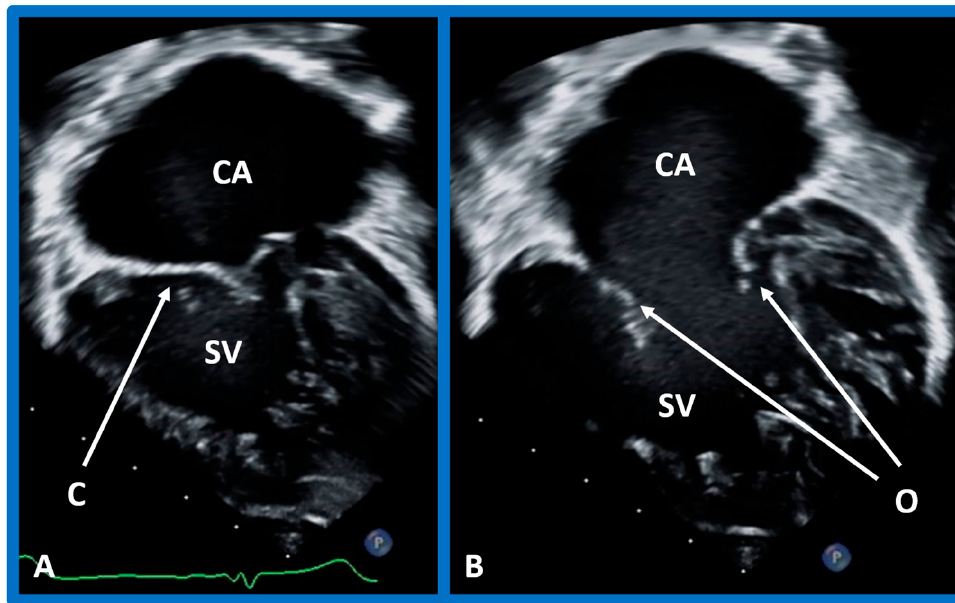
Figure 43. Echo frames in apical four-chamber views demonstrating a connection of common atrium (CA) with single ventricle (SV) by a one (common) atrioventricular valve. In ( A ), the common atrioventricular valve is closed (C), whereas in ( B ), it is open (O). Heavy trabeculation is seen in the SV.